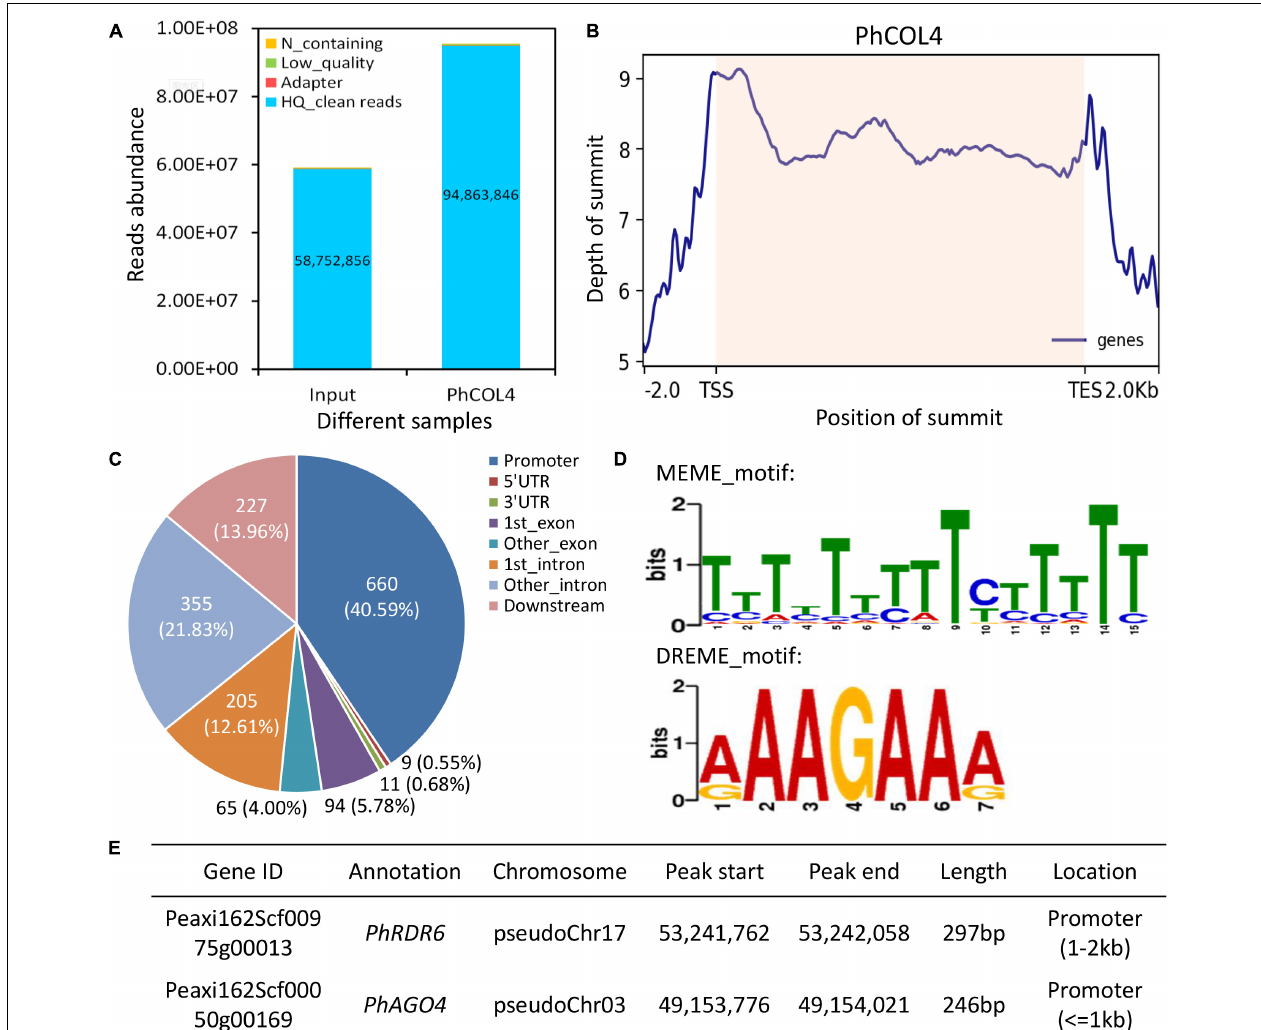
FIGURE 9 | Binding peaks and motifs of PhCOL4 by DNA affinity purification sequencing in petunia. (A) Abundance of reads from PhCOL4-bound DNA affinity purification sequencing (DAP-Seq) database. (B) Distribution of summits in peaks around transcription start sites (TSS) and end sites (TES) of genes. Summit positions within transcribed regions are shaded. (C) Number of peaks in different genomic categories. The promoter indicates the 2 kb region upstream of TSS, and the downstream represents the 2 kb region downstream of TES. (D) Two top DNA motifs bound by PhCOL4 from MEME and DREME analyses of DAP-Seq database. (E) Two putative PhCOL4-bound peaks and corresponding RNA silencing-related